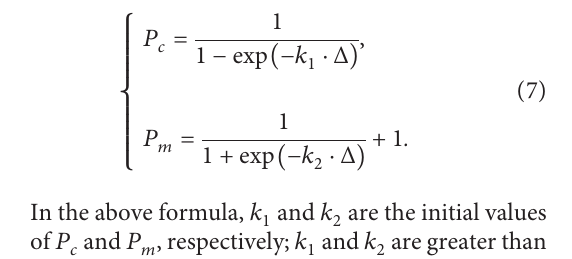
Figure 6: Control structure of adaptive genetic fuzzy double closed